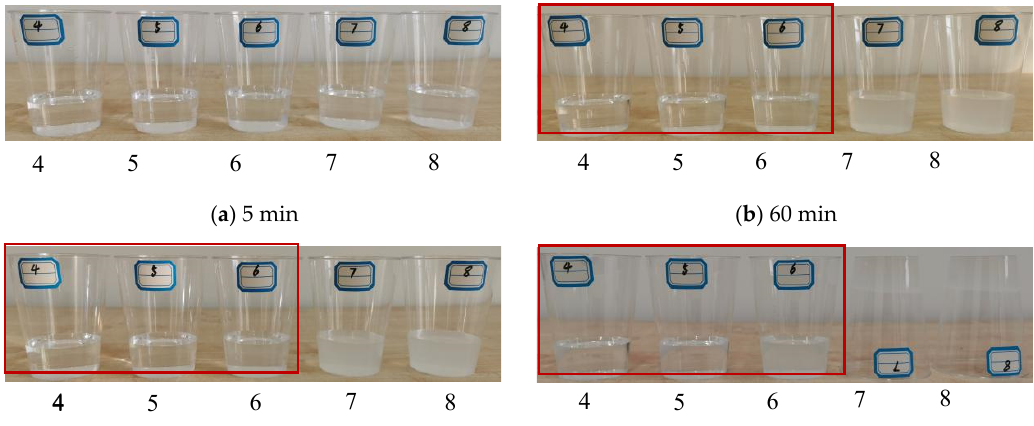
Figure 4. The effects of pH value on the stability of precursor solutions of NS.